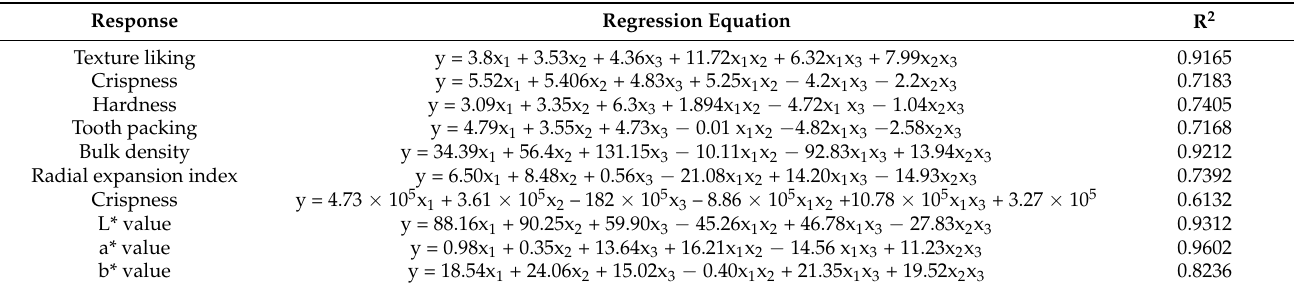
Table 7. Stepwise regression equations and their coefficients of determination for responses.